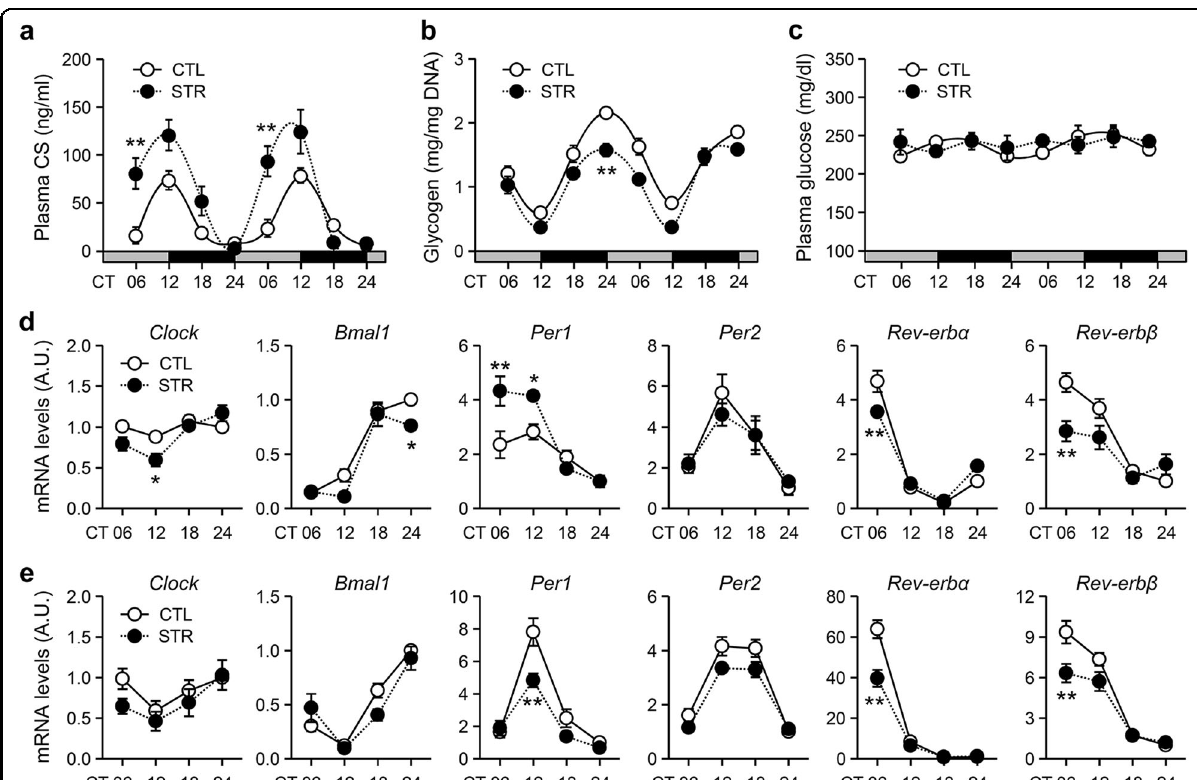
Fig. 5 In fl uences of maternal stress on peripheral rhythms in adult male offspring. a Plasma CS concentration ( n = 8 CTL mice and n = 6 STR mice at each point), b hepatic glycogen content ( n = 7 CTL mice and n = 5 STR mice), and c plasma glucose levels ( n = 8 CTL mice and n = 6 STR mice). The mice were housed under DD conditions and sacri fi ced at the indicated time points over a 2-d period. The data are presented as the mean±SE in the indicated units (** p <0.01 vs. CTL mice at the same time point by Bonferroni post hoc comparison). d , e mRNA expression pro fi les of clock genes in the adrenal gland ( d ) and liver ( e ). The data were normalized against TBP expression levels and are expressed as the mean±SE in A.U., with the mean CTL value at CT24 being de fi ned as 1 ( n = 4 for each point, * p <0.05 and ** p <0.01 vs. CTL mice at the same time point by Bonferroni post hoc